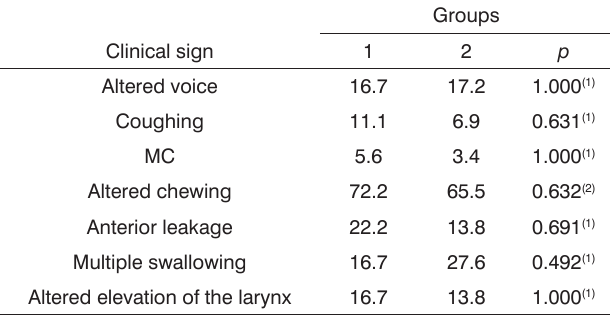
Table 2. Percentage of signs that were encountered.